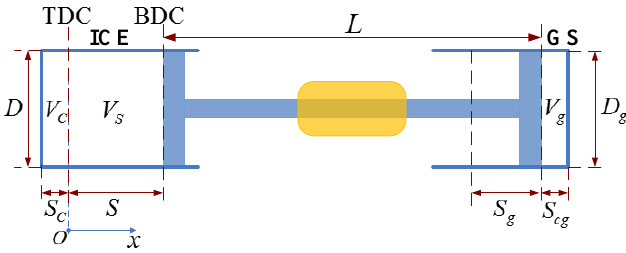
Figure 6. Crucial geometric parameters description of FPLG.